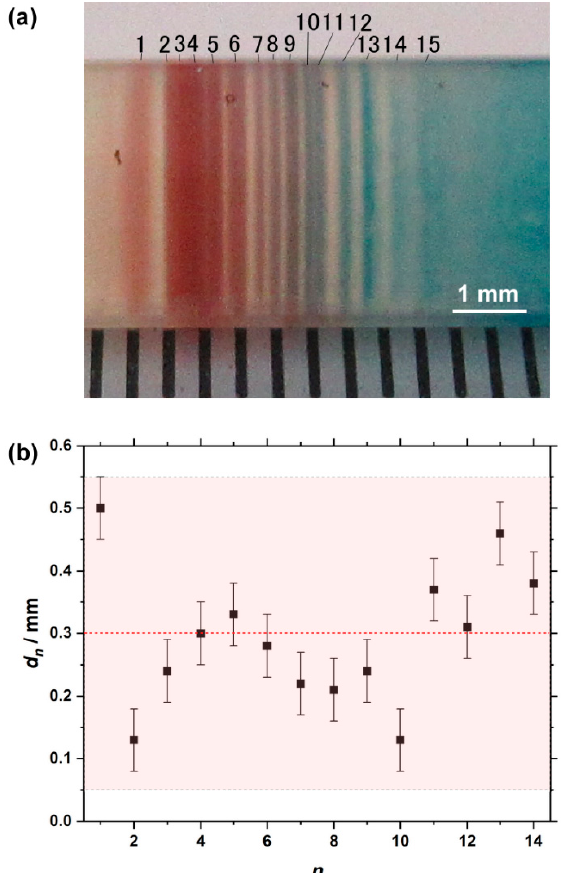
Figure 10. ( a ) Periodic bands formed in the sample tube under the cyclic alternating voltage appli- cation. The bands are numbered from 1 (the cathode side) to 15 (the anode side). For comparison, 0.5 mm graduations are also shown at the bottom of the image. ( b ) Distances between the adjacent bands in ( a ): d n = X n +1 − X n . The average value and dispersion are shown by the red broken line and pink shaded area, respectively.